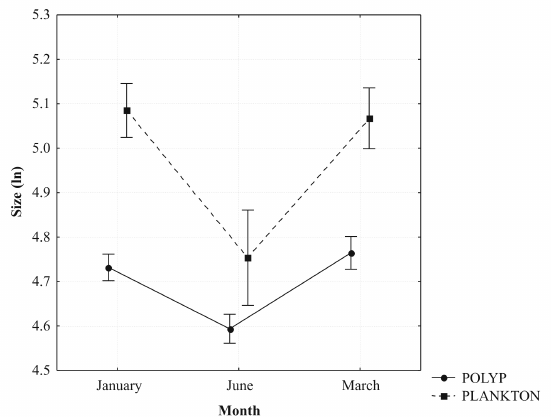
Fig. 3- First-order interaction between sites (polyps of Carijoa riisei and plankton) and months on ln transformed mean of prey size at Porto de Galinhas